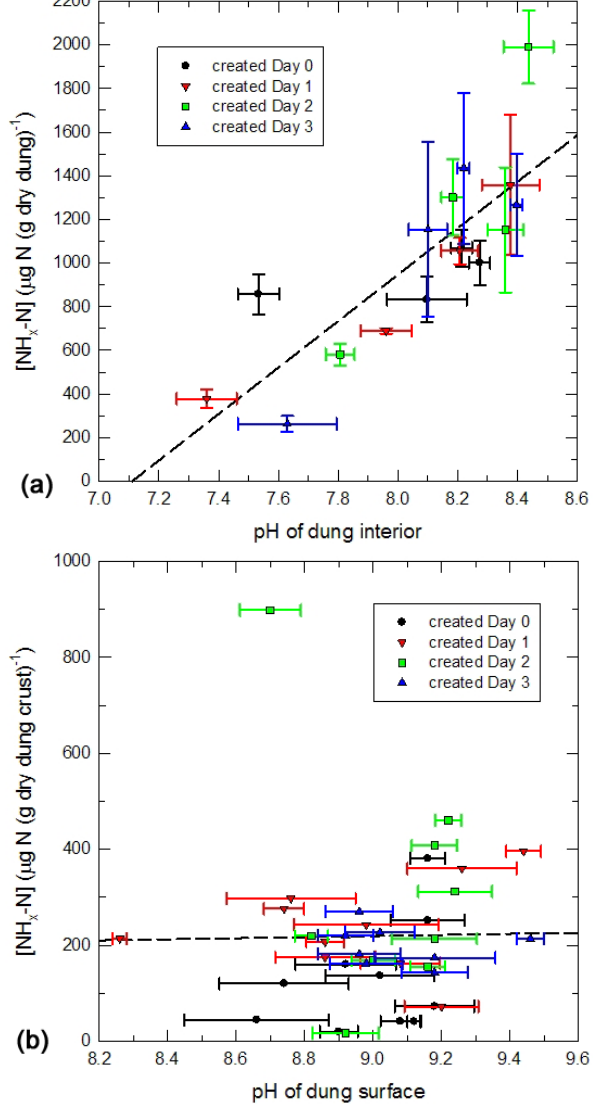
Fig. 4. (a) NH x -N concentration in samples from the dung interior versus pH of the same samples. The different dung pats are identi- fied by different symbols (same as in Fig. 3). Error bars mark stan- dard errors of the mean of 3 replicates. The dashed line represents linear regression ( R 2 = 0.66). (b) Same for NH x -N concentration of dung-crust samples versus pH on the dung surface (mean of 5 repli- cates). The linear regression has R 2 =